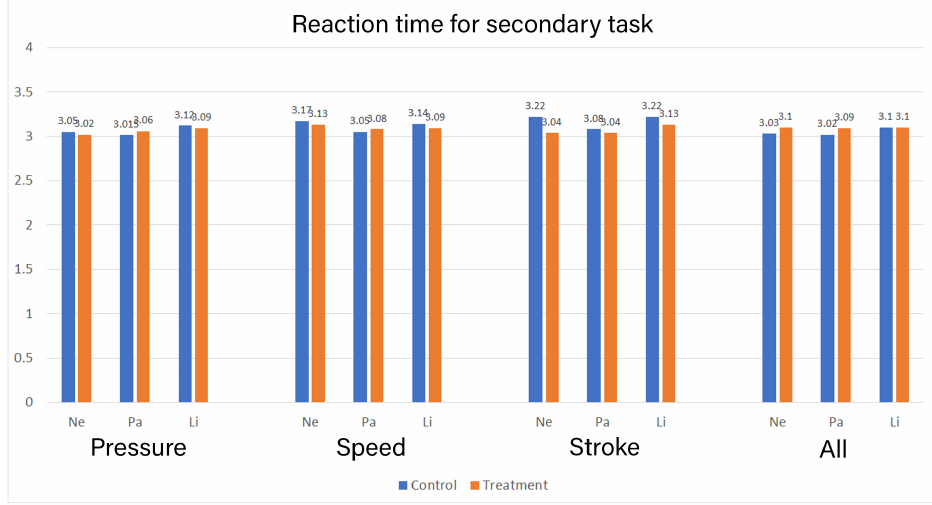
Figure 7. Mean of Reaction time between two groups [in